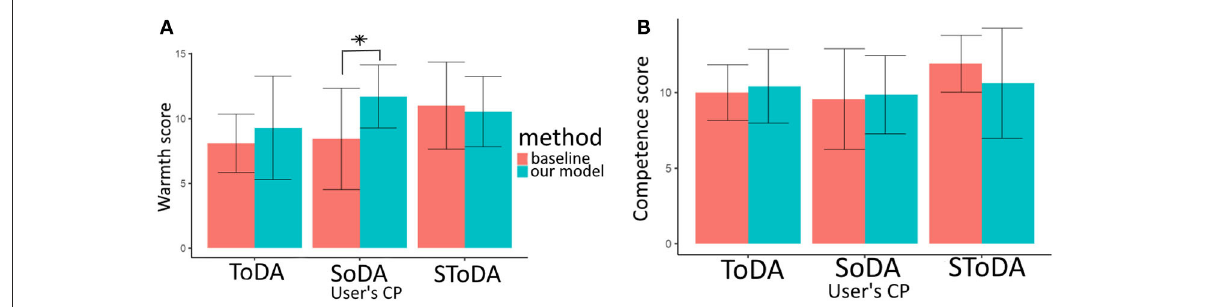
FIGURE8 Warmth (A) and Competence (B) scores. CP, conversational preferences; SoDA, socially-oriented dialog act; ToDA, task-oriented dialog act; SToDA, socially- and task-oriented dialog act. * p ≤